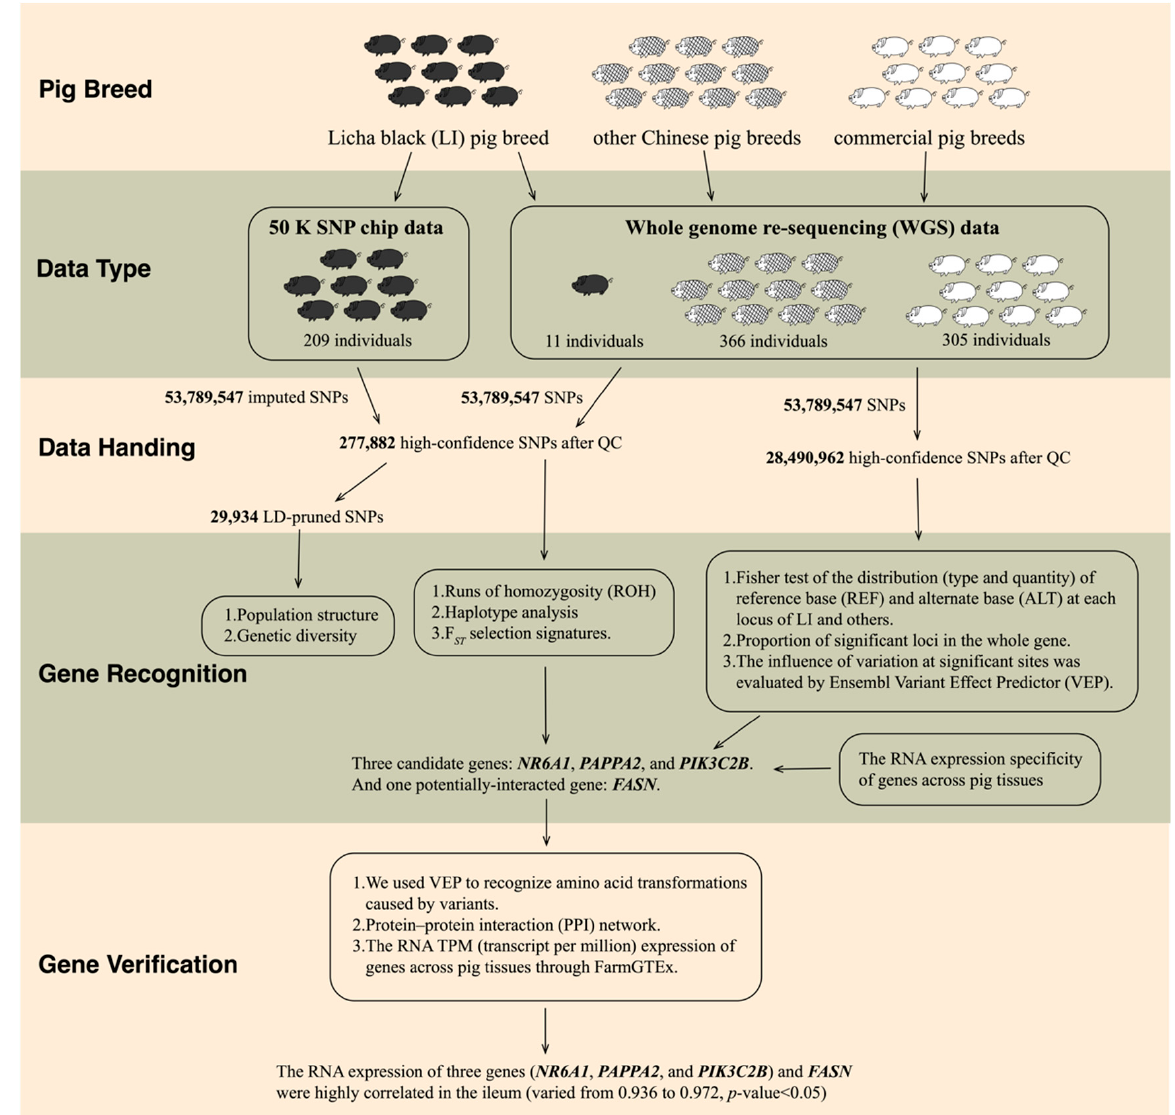
Figure I1. Process and data of this study. Figure 1. Process and data of this